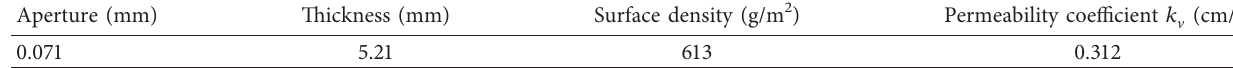
Table 1: Parameters of the permeable geotextile.